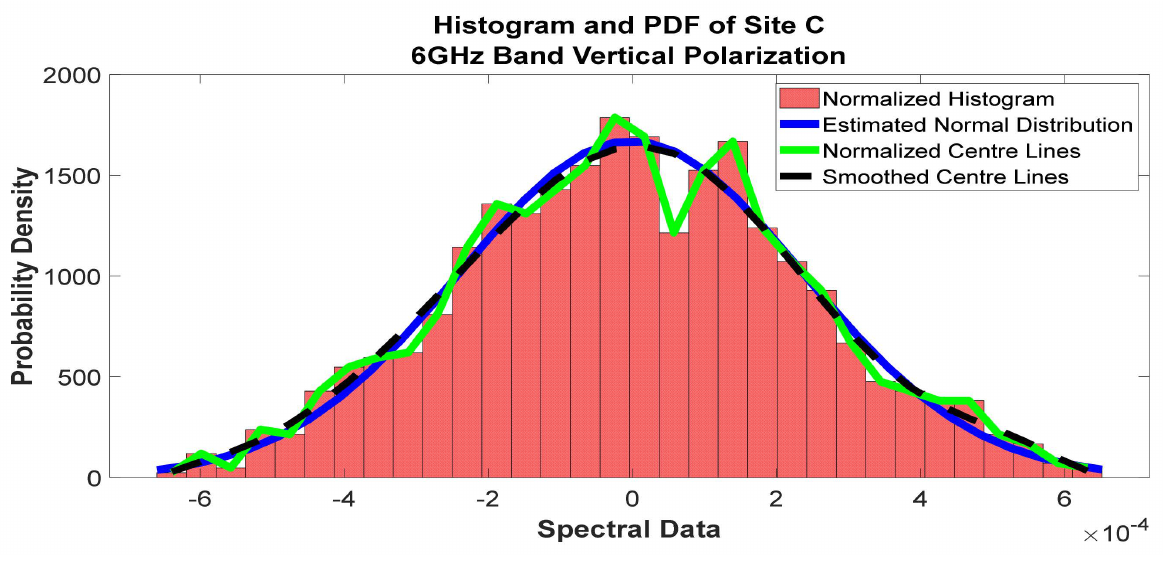
Figure 17. Histogram and PDF of the frequency scan for site C at 6 GHz vertical polarization.